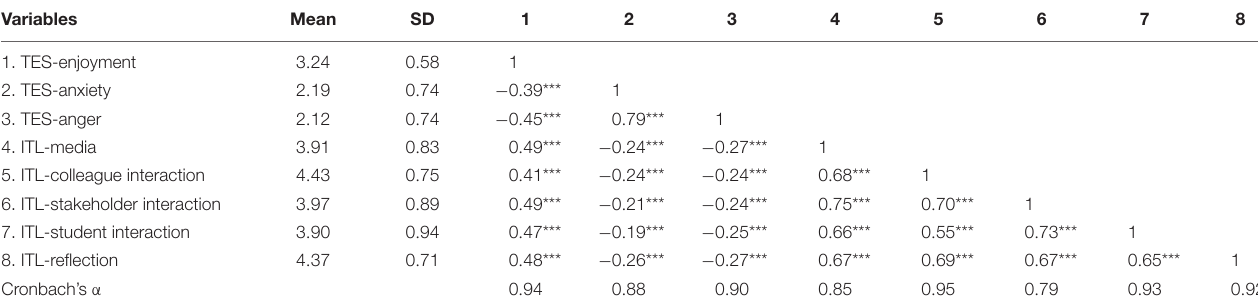
TABLE 2 | Descriptive statistics, Cronbach’s alpha, and correlations between the eight variables ( N = 2880). Variables